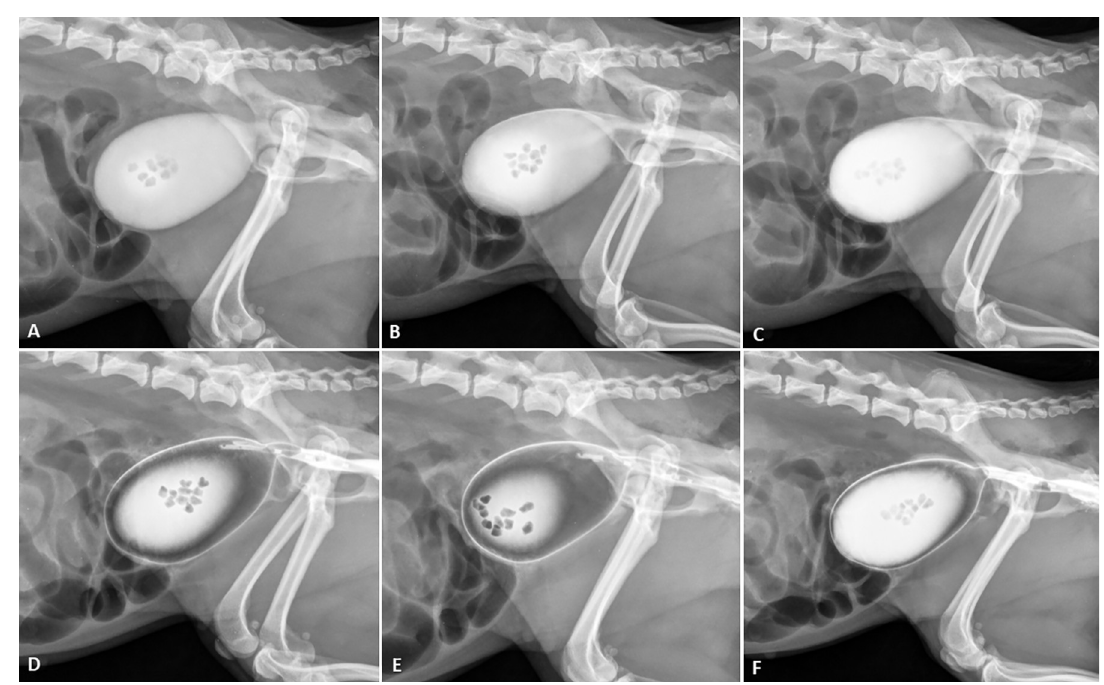
Fig 1. Left lateral radiographic projections using positive contrast tests and double contrast when 12 uroliths were inserted into the bladder. In (A) 5% positive contrast, showing easier visualization of uroliths; (B) 10% positive contrast; (C) 20% positive contrast; (D) double contrast 1; (E) double contrast 2; (F) double contrast